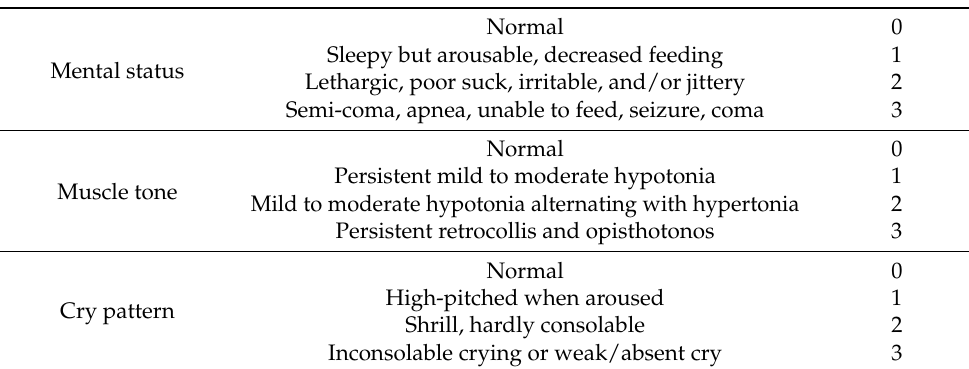
Table 3. Bilirubin-Induced Neurologic Dysfunction (BIND) score